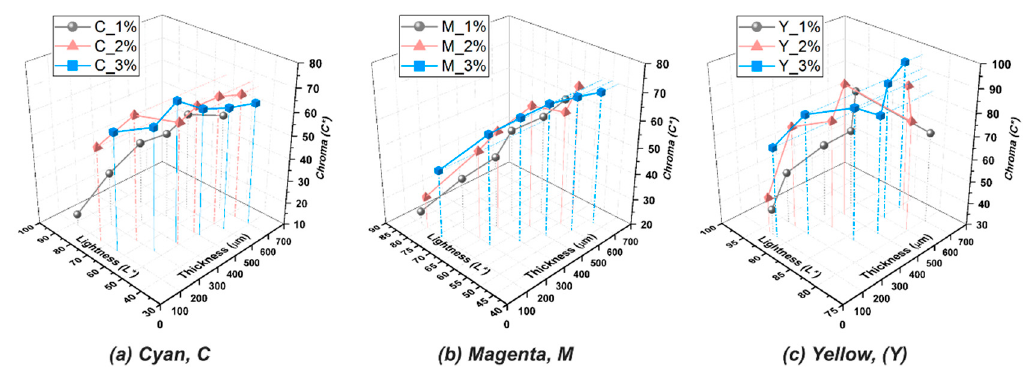
Figure 5. Thickness–lightness–chroma 3D plots for evaluating the color appearances of the prepared resins in ( a ) cyan, ( b ) magenta, and ( c ) yellow primary colors.